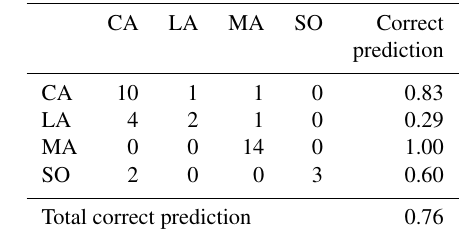
Table 3. Confusion matrix of fish region classification by QDA (sample origin rows, predicted origin columns). CA is the Central Amazon; LA is the Lower Amazon; MA is Madeira basin; SO is the Solimões